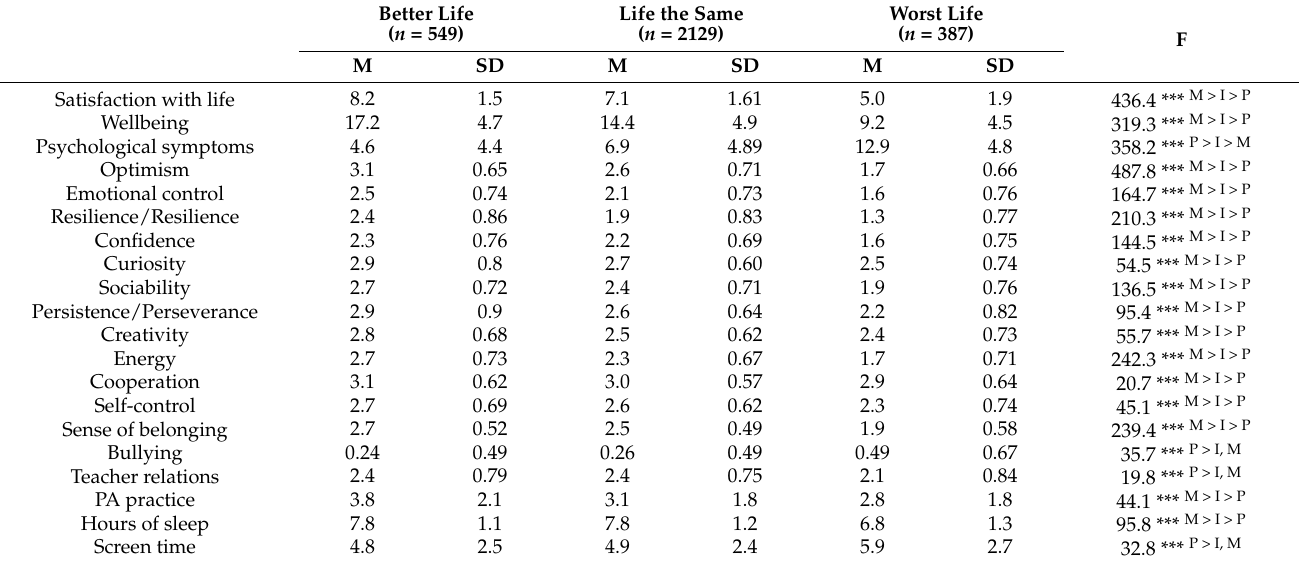
Table 6. Comparisons between groups, according to the assessment of current life, in lower secondary school students and upper secondary school